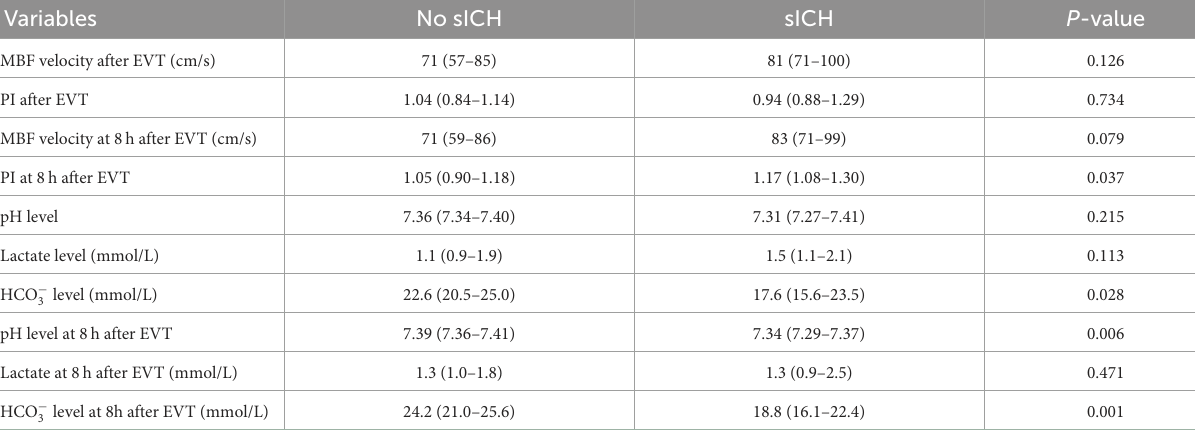
TABLE 2 Comparison between favorable and poor prognosis according to the outcome: Symptomatic intracranial hemorrhage. Variables